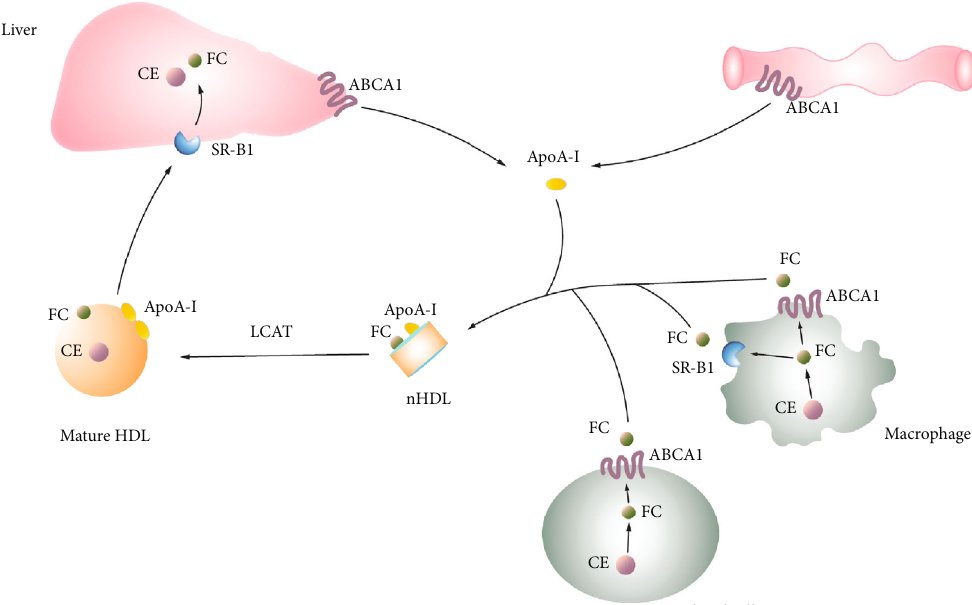
Figure 1: Diagram of reverse cholesterol